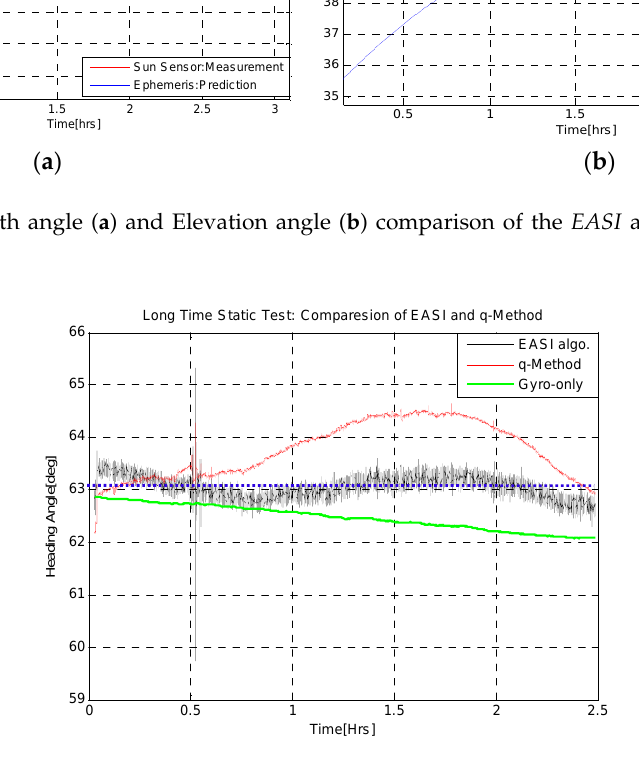
Figure 10. Rover heading angle estimation during the 2.5 h static test. Comparison of the EASI algorithm and the Optimization based q ‐ Method . Table 2. Statistical comparison of heading estimation algorithms.